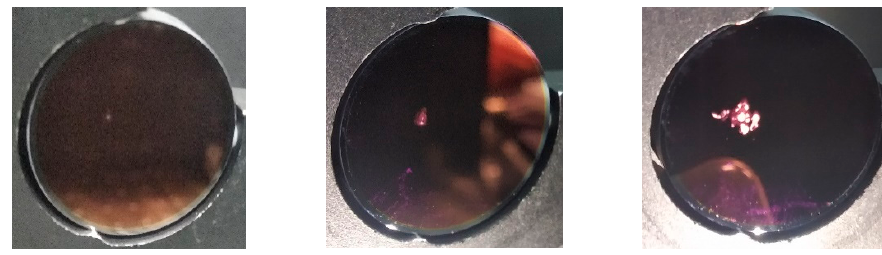
Figure 6. Damage phenomenon of the Si window with long-pulse laser irradiation.